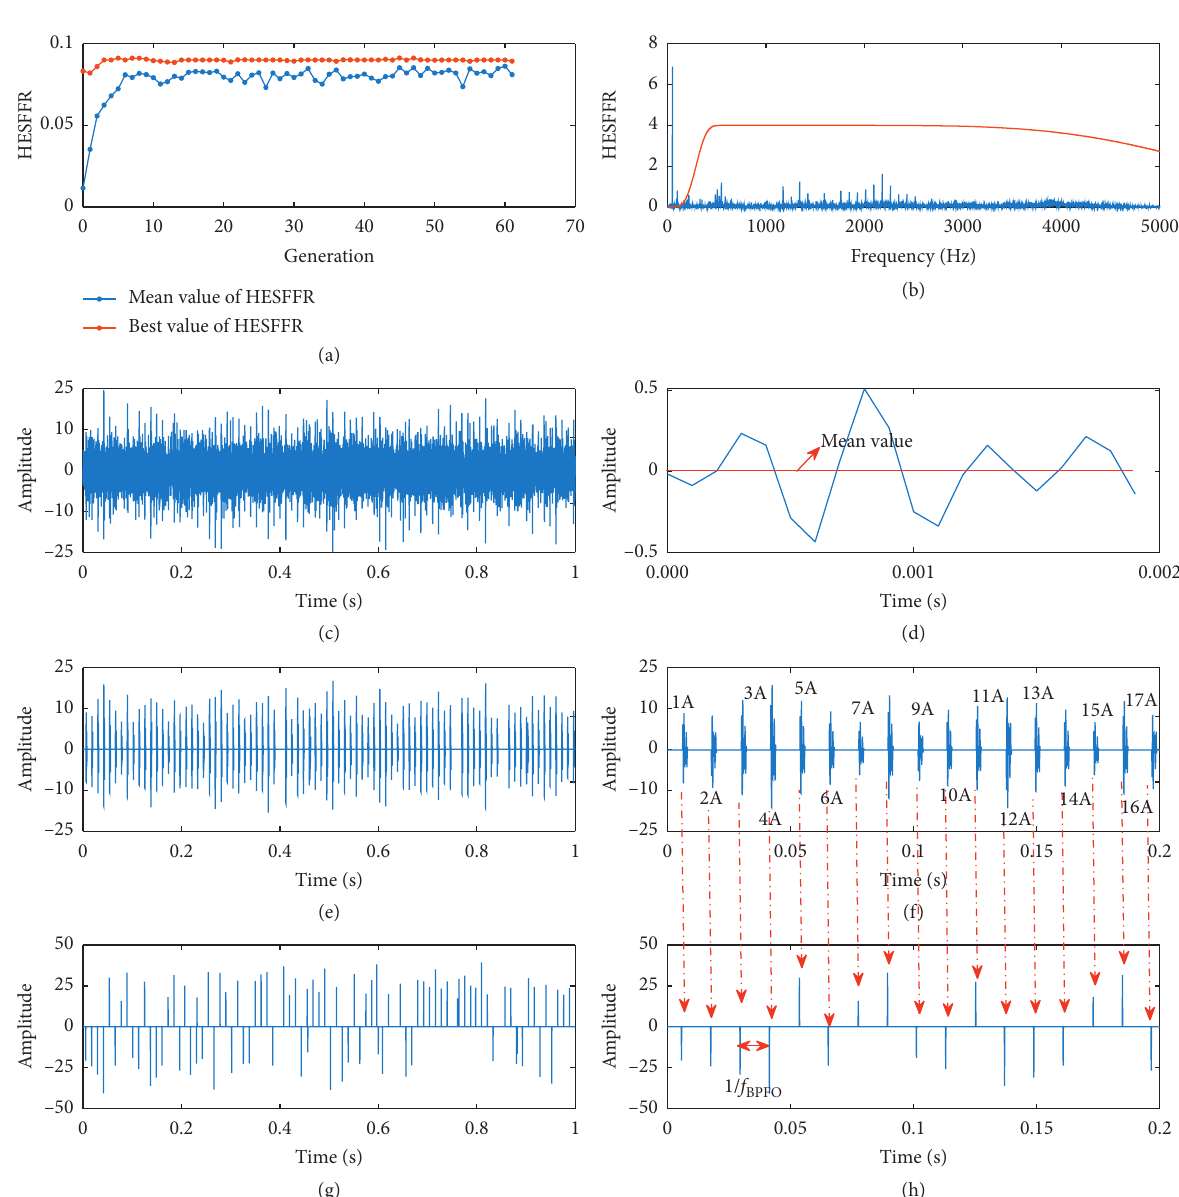
Figure 20: AUC-DLA-OB for identification of wheelset bearing outer race fault. (a) Convergence process of solving constrained opti- mization problems; (b) filtering frequency band related to fault impulses; (c) filtered signal by filters in Figure 20(b); (d) learned shock responses; (e) sparse reconstruction signal; (f) locally zoomed figure of the impulses shown in Figure 20(e); (g) obtained location co- efficients; and (h) locally zoomed figure of the location coefficients shown in Figure